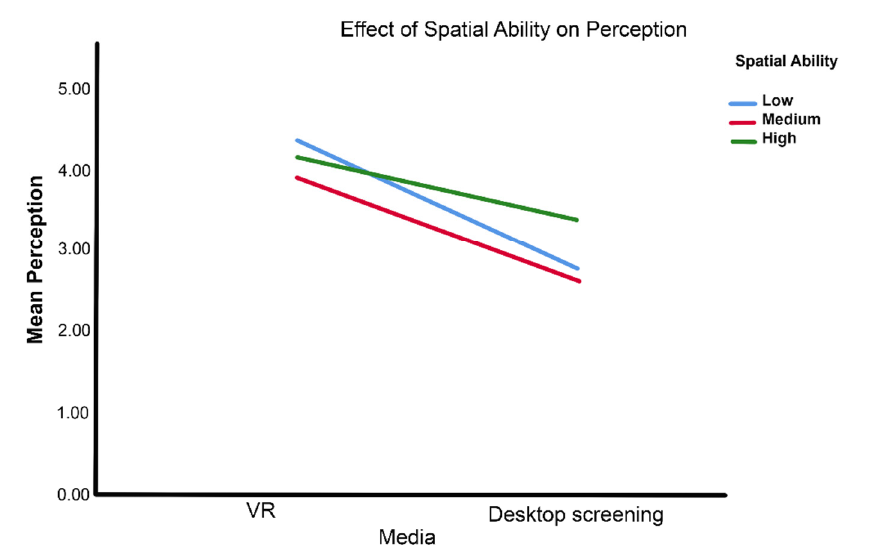
Figure 11. E ff ect of spatial ability on student satisfaction, usability, and Figure 11. Effect of spatial ability on student satisfaction, usability, and perception.